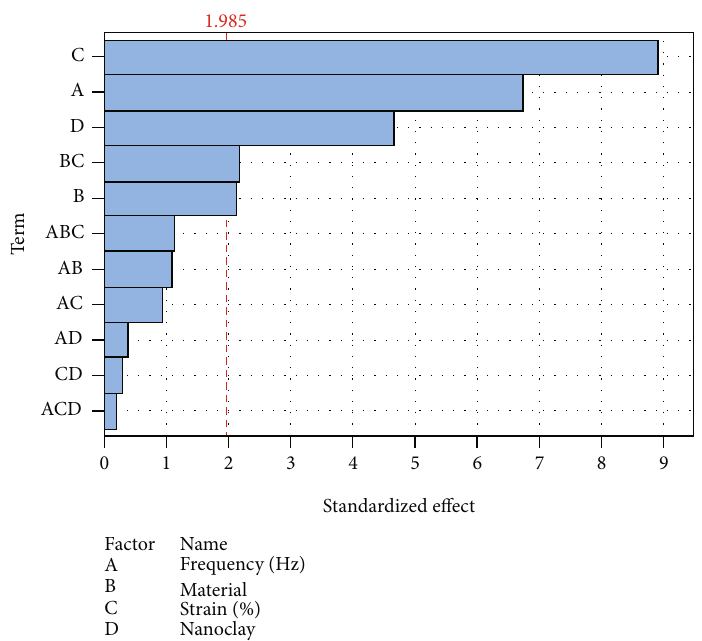
Figure 11: Sensitivity analysis of rubber fatigue life in terms of strain amplitude, amount of nanoclay in the composition, and test frequency